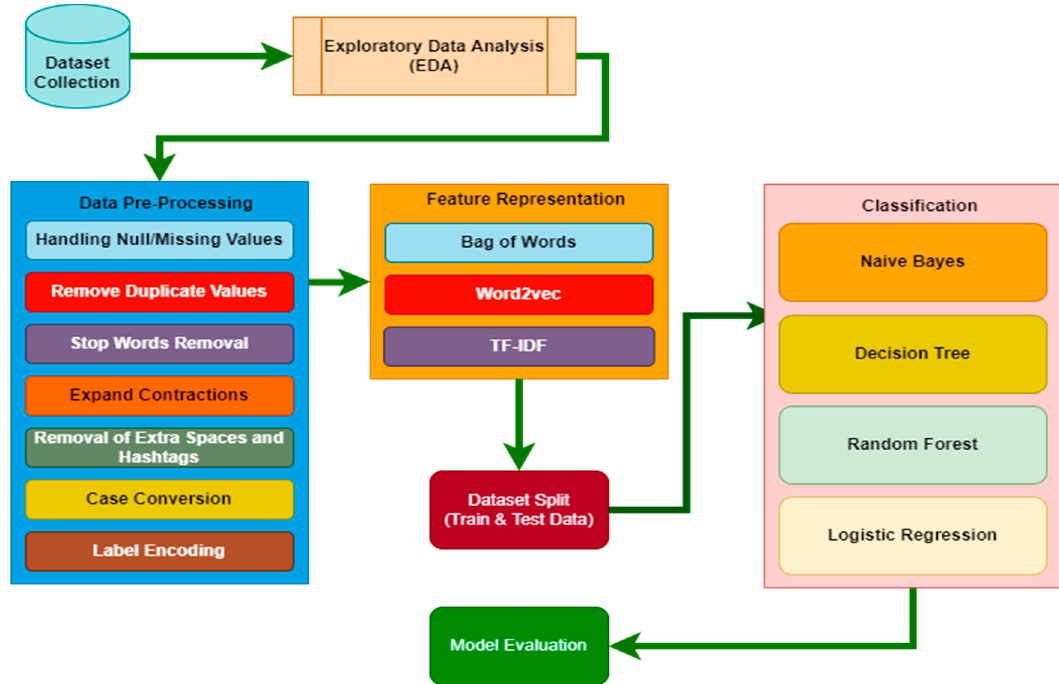
Figure 1. Proposed System Model.